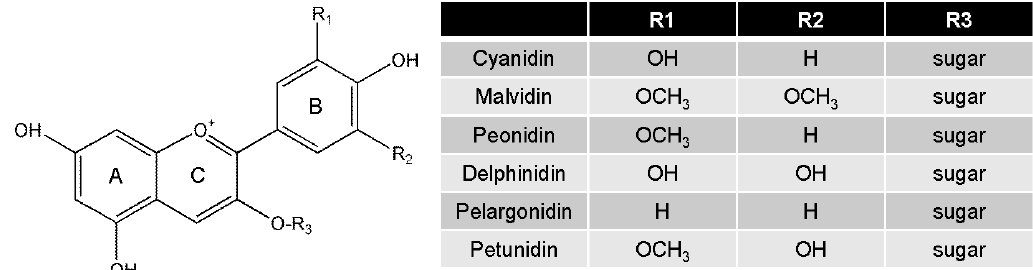
Figure 1. Structure of the most common anthocyanins.